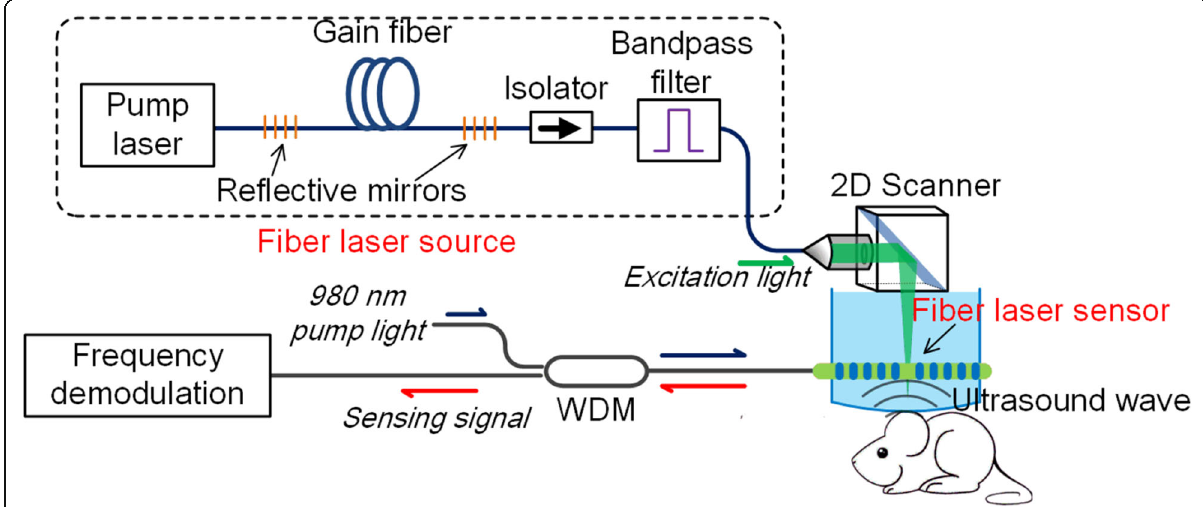
Fig. 1 Schematic of fiber-laser-based PAM. Multiwavelength, high-repetition-rate pulsed fiber lasers are used for photoacoustic excitation. A distributed-Bragg-reflector fiber laser is used to detect optically induced ultrasound